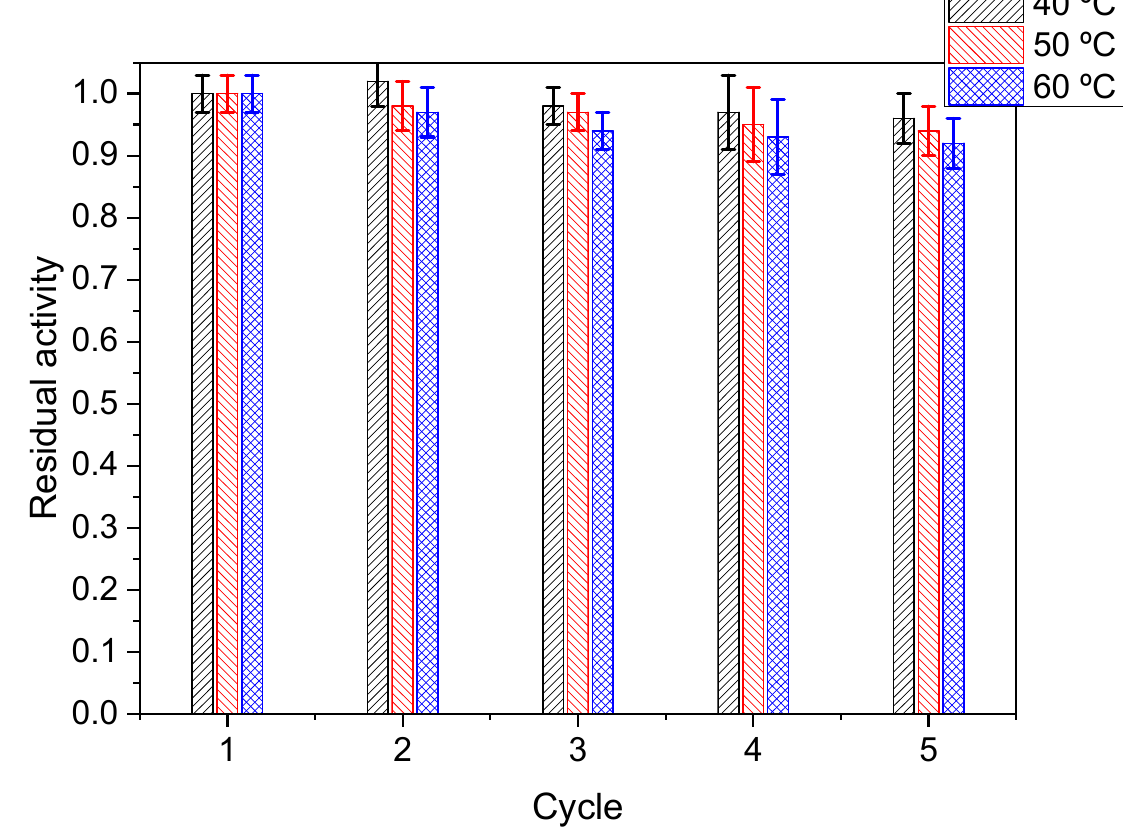
Figure 5. Evolution of the residual activity of Lipozyme ® TL IM at 40, 50 and 60 °C for five consecutive reaction cycles. Fixed conditions: TG to MA molar ratio 1:13, enzyme percentual concentration 30% (C E = 140 g/L).